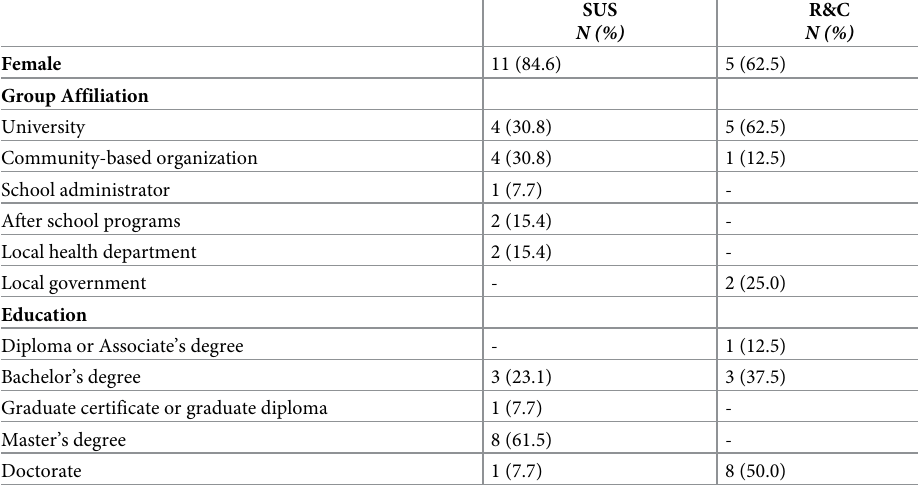
Table 2. Demographics and affiliation information of survey participants from Shape Up Somerville (SUS) and Romp & Chomp